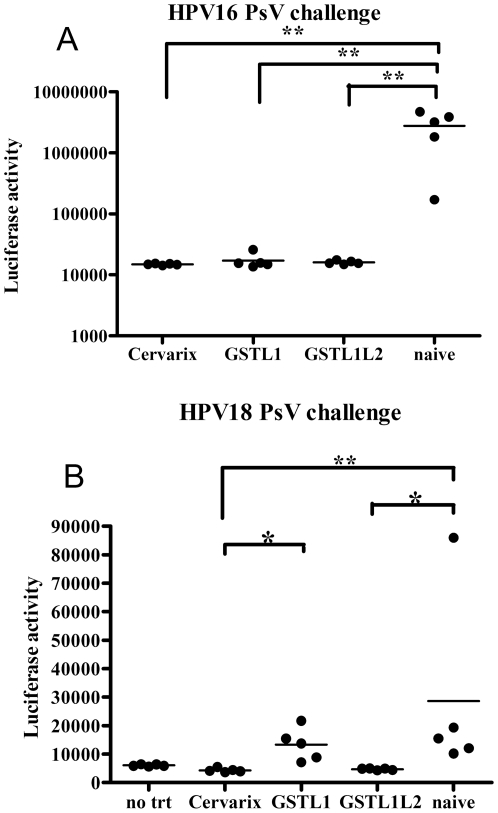
Vaginal challenge of mice with HPV PsV after immunization with capsomers.Mice were subcutaneously immunized with GST-HPV16L1Δ, GST-HPV16L1Δ-L2x3 or Cervarix® three times at two-week intervals. Three and five weeks after the last immunization, the mice were challenged with either HPV16 (A) or HPV18 (B) PsV carrying a luciferase reporter, respectively. Three days after challenge, the mice received an intravaginal instillation of 20 µl of D-luciferin and were imaged with a Xenogen IVIS 100 system (image captured for 10 min post-installation of luciferin). Image analysis in each experiment was based on the average measurement (photons/s/cm2) collected from each selected equally-sized area (A, 1.9 cm2; B, 0.6 cm2) in the vaginal tract.